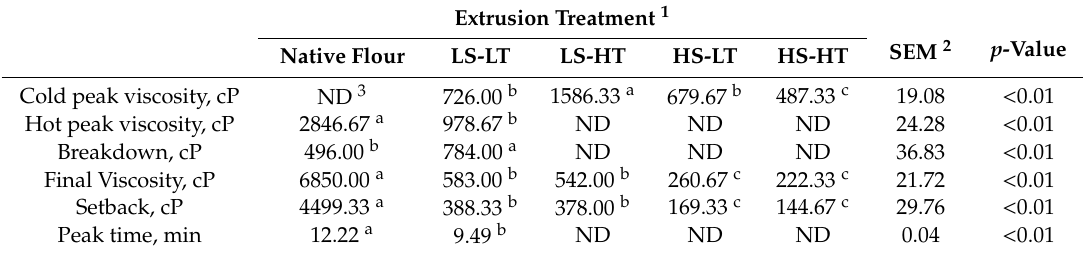
Table 3. E ff ects of modification of breadfruit flour with extrusion on pasting properties of